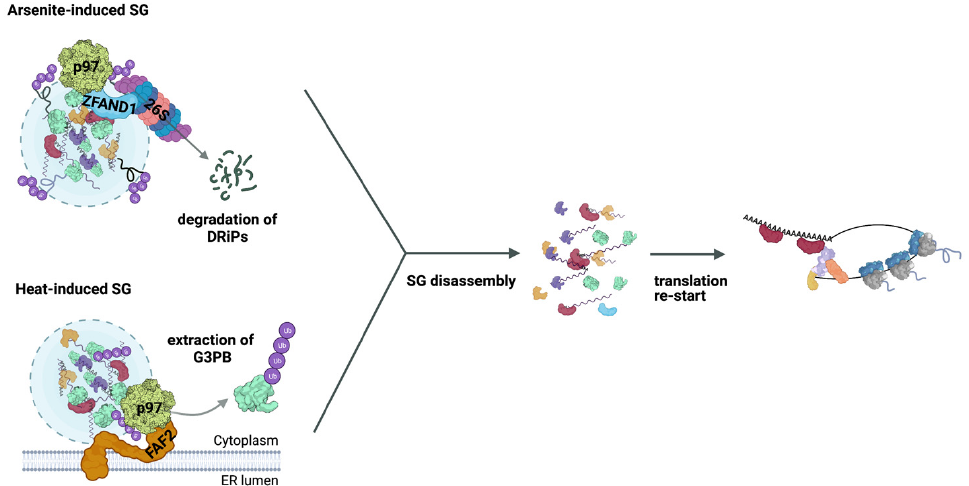
Figure 2. SG disassembly by p97 and its cofactors. Top: The p97 cofactor ZFAND1 (blue) associates with arsenite-induced SGs and recruits both p97 (yellow) and the 26S proteasome, promoting SG disassembly by removing ubiquitylated (purple), presumably misfolded proteins, such as DRiPs. Bottom: The ER membrane-localized p97 cofactor FAF2 (orange) recruits p97 to heat-induced SGs, where it promotes disassembly by removing ubiquitylated G3BP. After SG disassembly, productive translation initiation complexes can form to restart translation.